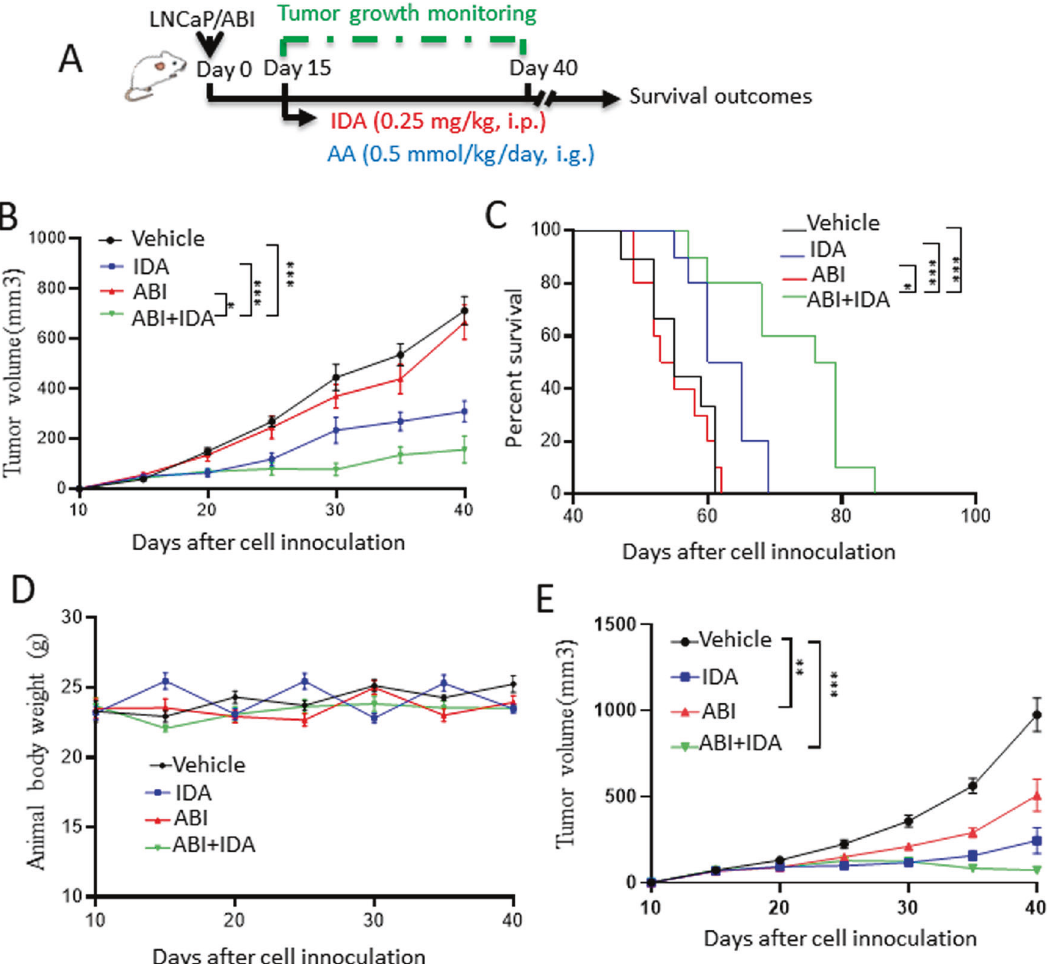
Fig. 2 IDA combats abiraterone resistance in vivo. A – D LNCaP/ABI cells were injected subcutaneously into the fl anks of 8-week-old castrated male null mice. When tumor sizes reached about 50 mm 3 , mice were administered with the vehicle (10% DMSO plus 90% corn oil mixture as control, n = 8), IDA (0.25 mg/kg, i.p.), AA (0.5 mmol/kg, i.g.), and combination AA(0.5 mmol/kg, i.g.) and IDA(0.25 mg/kg) ( n = 10, per group) ( A ). Tumor volume ( n = 10, per group) ( B ), survival ( n = 10, per group) ( C ), and body weight ( n = 10, per group) ( D ) were monitored as indicated days. E LNCaP cells were injected subcutaneously into the fl anks of 8-week-old castrated male null mice. Mice were treated as shown in Fig. 2A. Tumor volume was monitored as indicated days ( n = 7, per group). Data are presented as means ± s.e.m. The statistical signi fi cance of tumor growth ( B , E ) and body weight ( D ) were measured by two-way ANOVA analysis. Statistical analysis for overall animal survival ( C ) was performed using and Log-rank (Mantel-Cox) test analysis, respectively. The asterisks indicate signi fi cant differences between the indicated groups (* p < 0.05, ** p < 0.01, *** p <